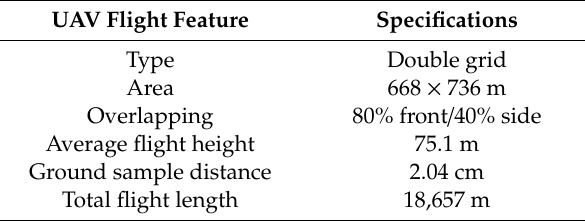
Table 3. Technical specifications of flight planning.